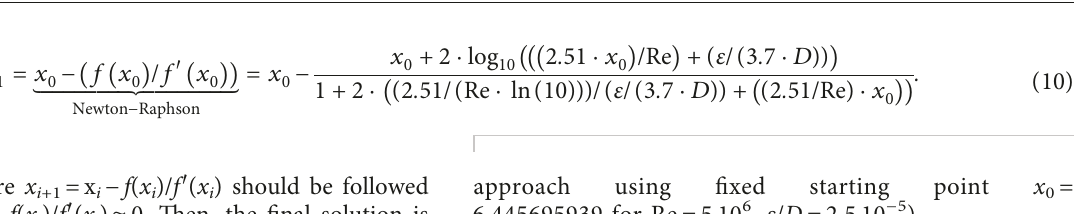
� 0.024069128765100981 from Section 2.2.1, calculation of λ : 0